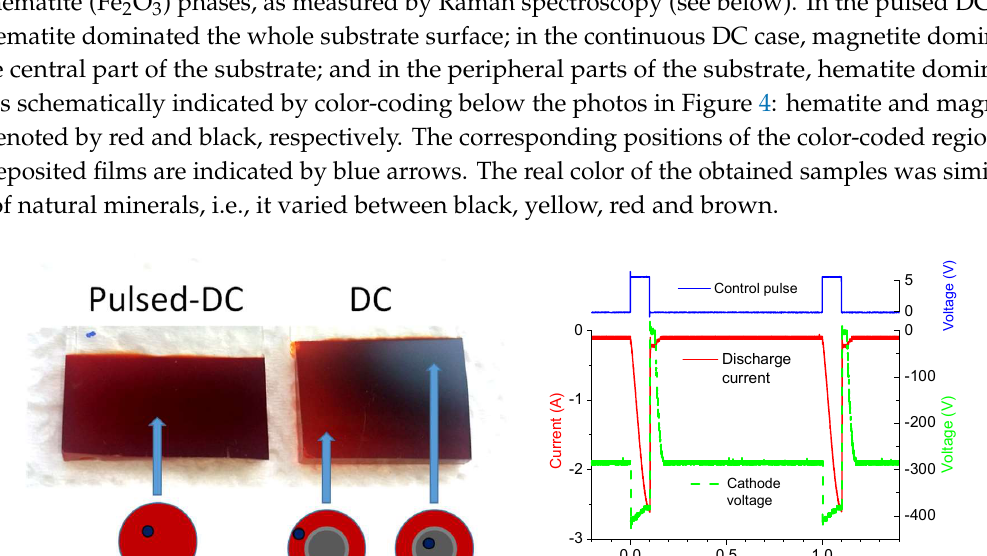
Figure 4. Photos of homogenous (pulsed-DC) and non-homogeneous (DC) iron oxide films on FTO glass substrate (left). The centers of schematic red circles correspond to the axis of the nozzle. Dark dots indicate the positions shown by arrows on the substrate. The discharge voltage and current waveforms during a typical pulsed DC operation with duty cycle of 10% and repetition frequency of 1 kHz are shown (right) .